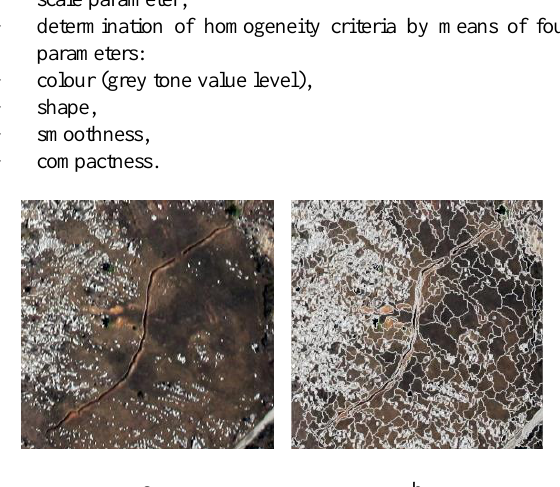
Figure 1. a) RGB image of the scene with a trench and shelter for heavy weapons, b) Segmented image on the basis of